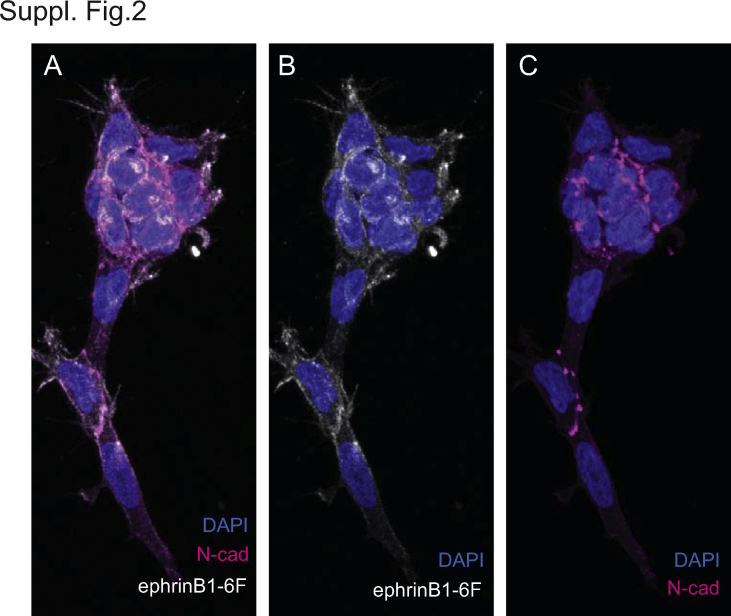
Relationship between ephrinB1-6F and N-cadherin. (A-C): immunostaining of a cluster of ephrinB1-6F cells to detect N-cadherin and ephrinB1-6F. N-cadherin is present in puncta at cell-cell contacts whereas ephrinB1-6F is more widely distributed and does not specifically co-localise with N-cadherin. These data are consistent with regulation of N-cadherin localisation by ephrinB1 signaling rather than formation of a complex between these proteins.